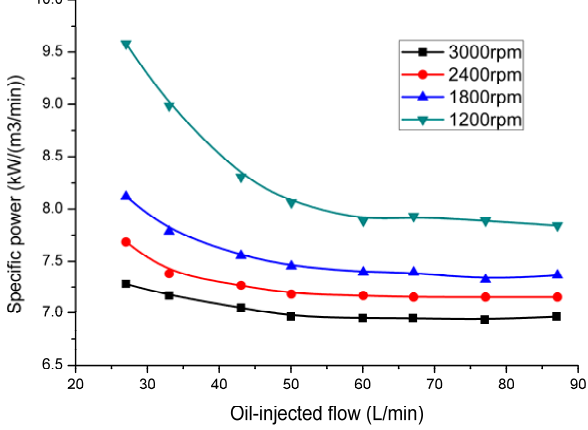
Figure 10. Variation of specific power with different oil injection flow rates.